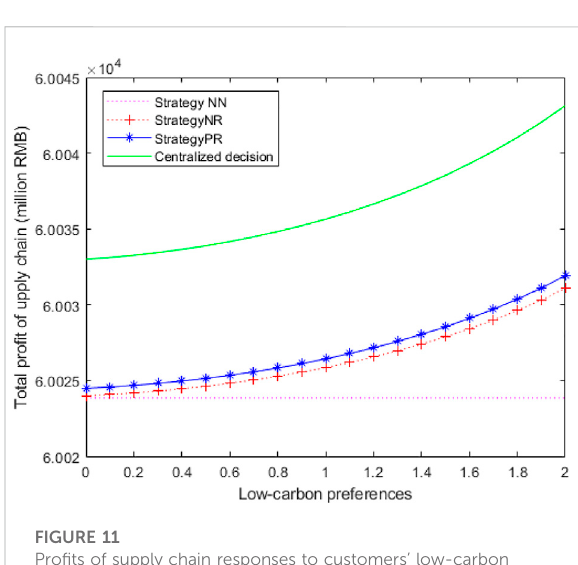
FIGURE 11 Pro fi ts of supply chain responses to customers ’ low-carbon